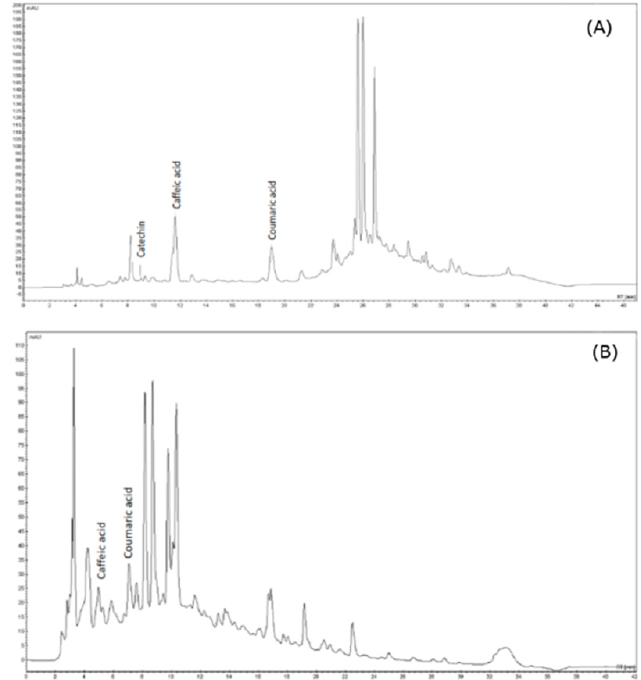
Figure 10. Representative HPLC chromatograms of phenolic compounds extracted from microcapsules and measured in a UV detector at 280 nm (catechin), 300 nm (coumaric acid) and 320 nm (caffeic acid). ( A ) protocol 1 and ( B ) protocol 2.